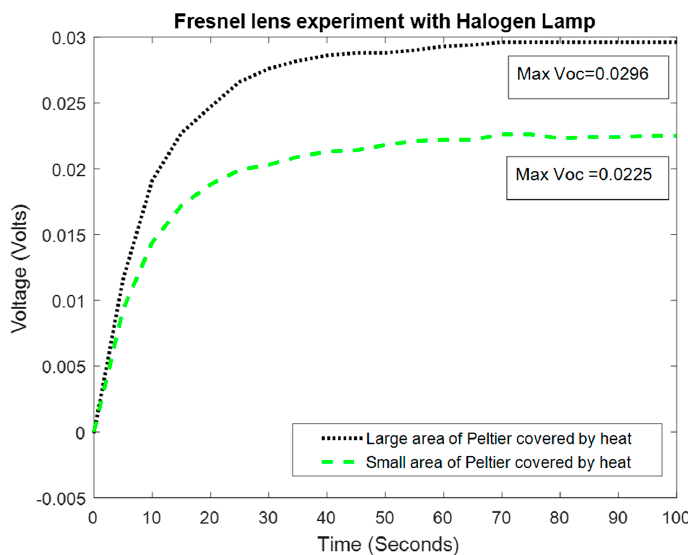
Figure 15. Graphical representation of the concentrated quartz-halogen heat and light showing the V oc covering the small and large surface area of the TEG module with respect to time in s.